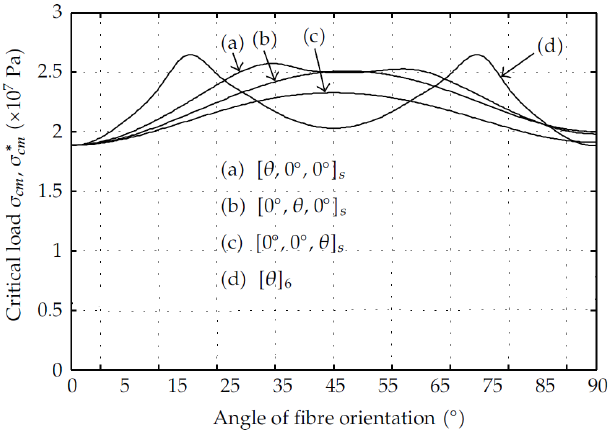
Figure 18. Critical buckling load versus varying inclined fibre orientation for different stacking sequences in GFRP cylindrical shells [167].